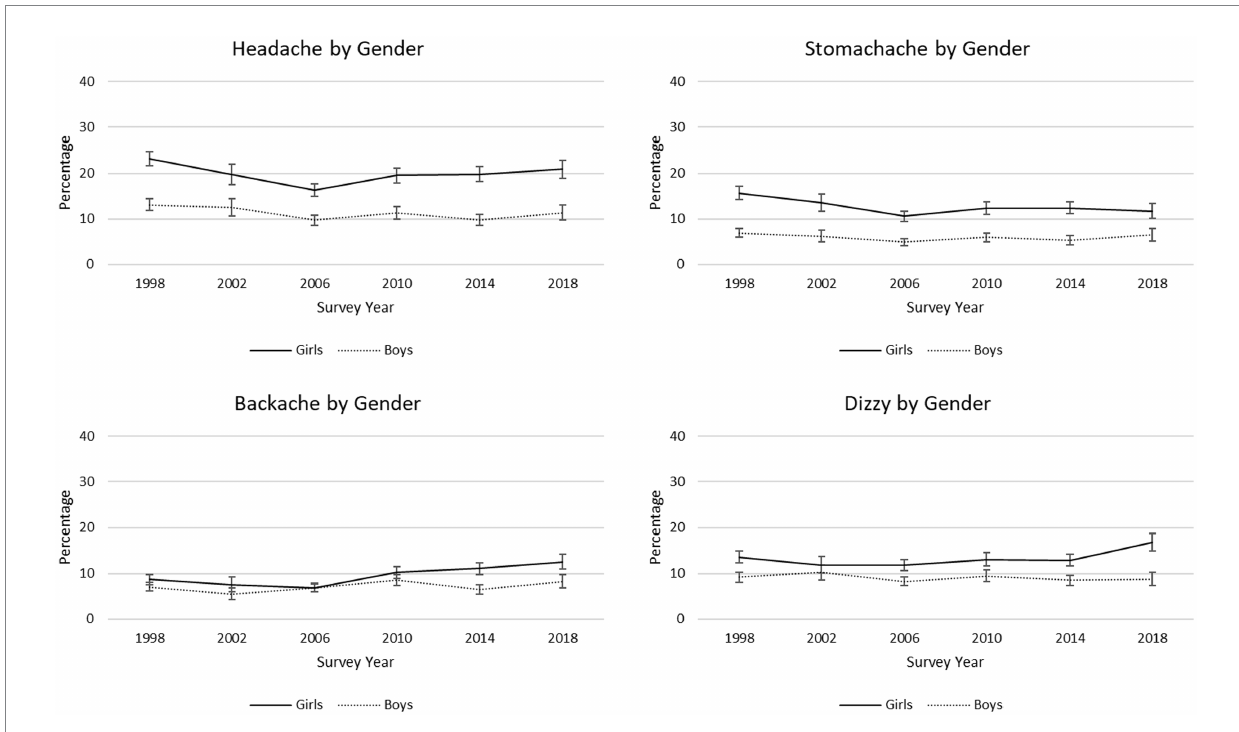
FIGURE 4 Trends in percentages of reported somatic symptoms, by gender. 95% confidence intervals are